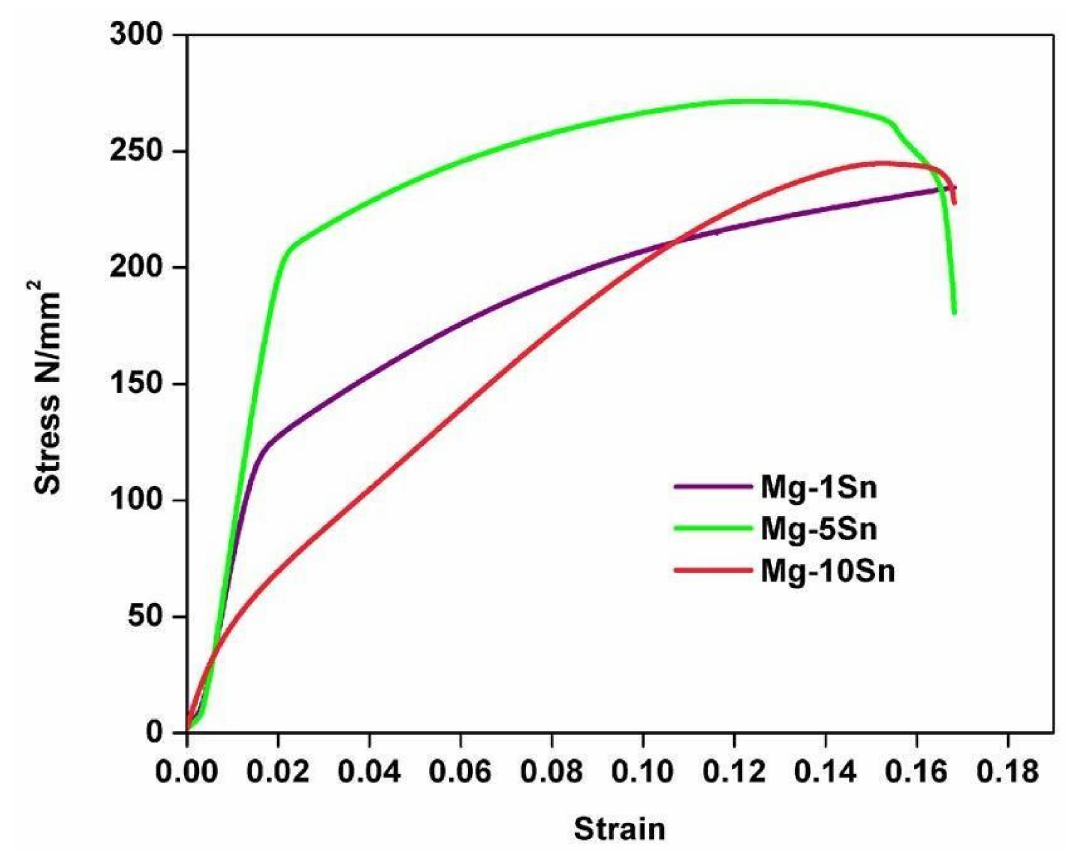
Figure 4. Compression curves of Mg-Sn alloys.